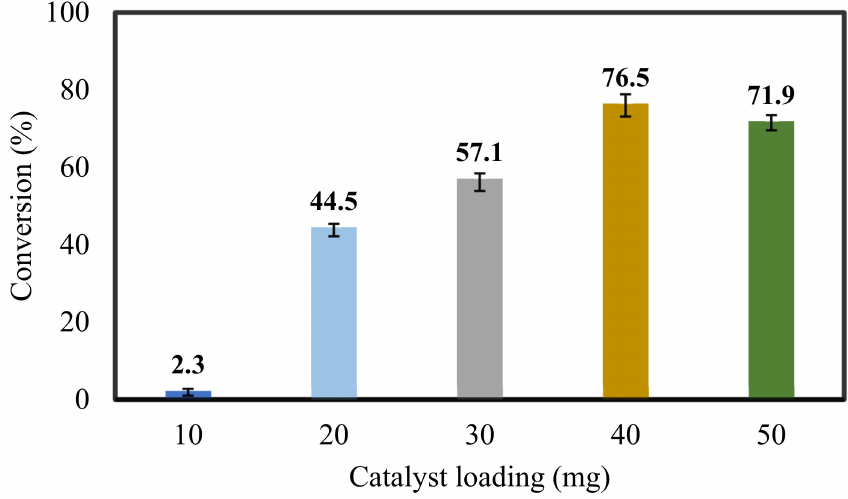
Figure 11. Effect of @PdCassCat loading. Conditions: furfural (10 mmol), base (Et 3 N) (10 mmol), formic acid (20 mmol), temperature 160 ◦ C, time (24